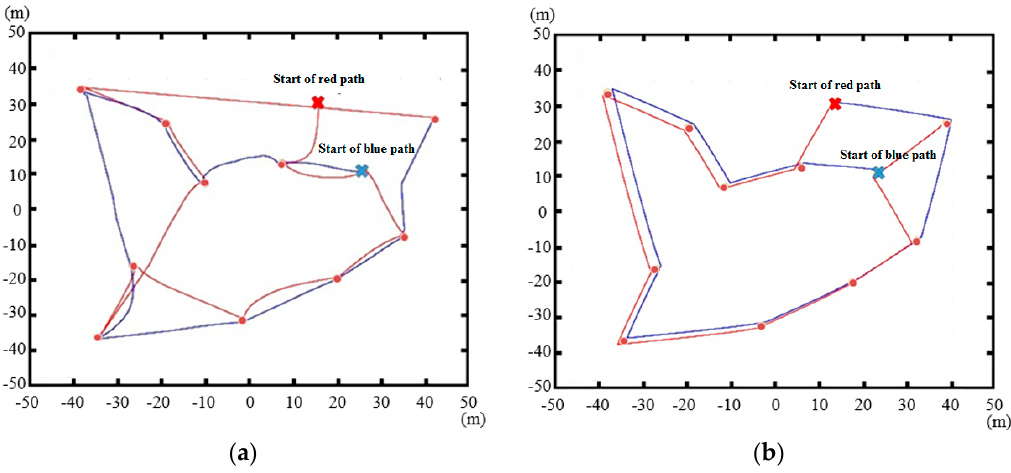
Figure 6 . Two different charging paths with different starting points: ( a ) omnidirectional antenna; and ( b ) directional antenna with 12 dB antenna gain.